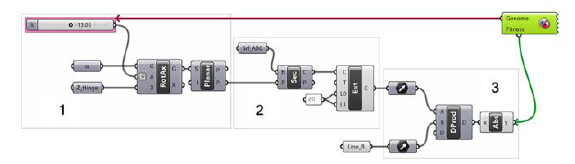
Figure 14. Instructions to the orientation spherical photomosaics With the Galapagos it was possible to manage the values progressively assumed by the variable λ, the angle of rotation of plane α, automatically assessing when the result equals the value established. The iteration activated by Galapagos ends when the scalar product of the vectors of the oriented segments is equal to 1. The program then returns the corresponding value assumed by the angle of rotation λ and the position of vertical plane α tangent to the sphere and parallel to plane β of the building. Likewise, the condition of parallelism was fixed between the horizontal lines passing through AB and